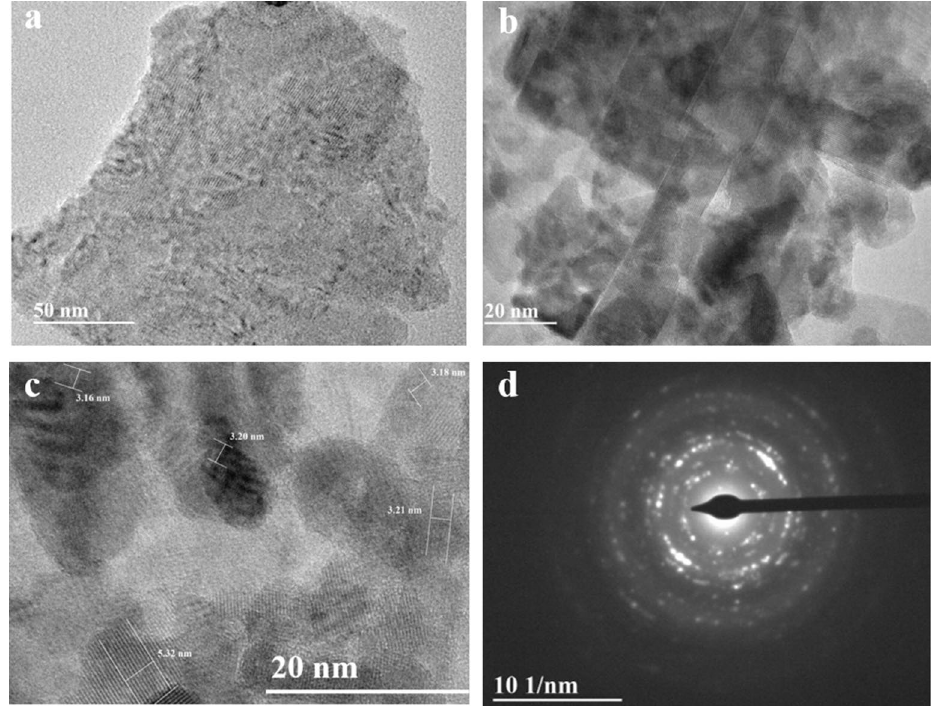
Figure 3. ( a ) Low-resolution TEM image. ( b ) TEM image. ( c ) HRTEM image. ( d ) SAED pattern of synthesized